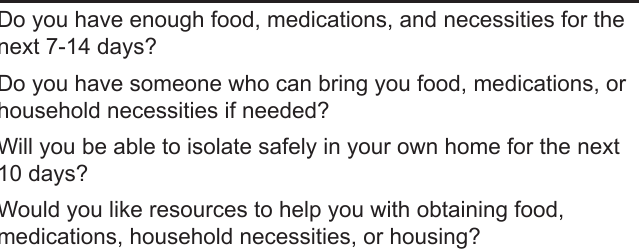
Table 1. Screening questions for health-related social